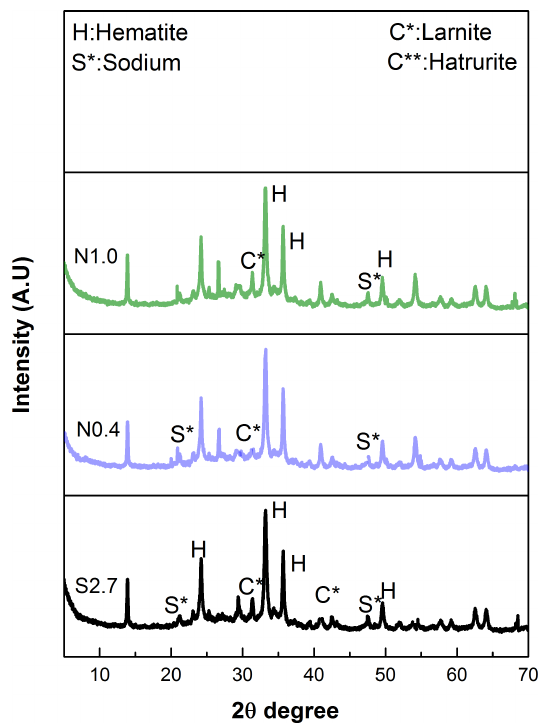
Figure 13: XRD spectra of S4.4, N0.4 and N1.0 at 28 days